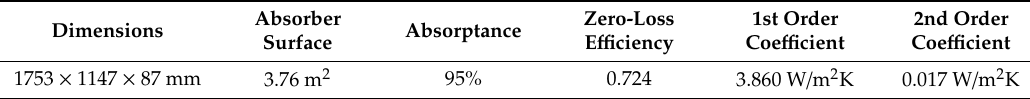
Table 2. Technical characteristics of the solar thermal collectors